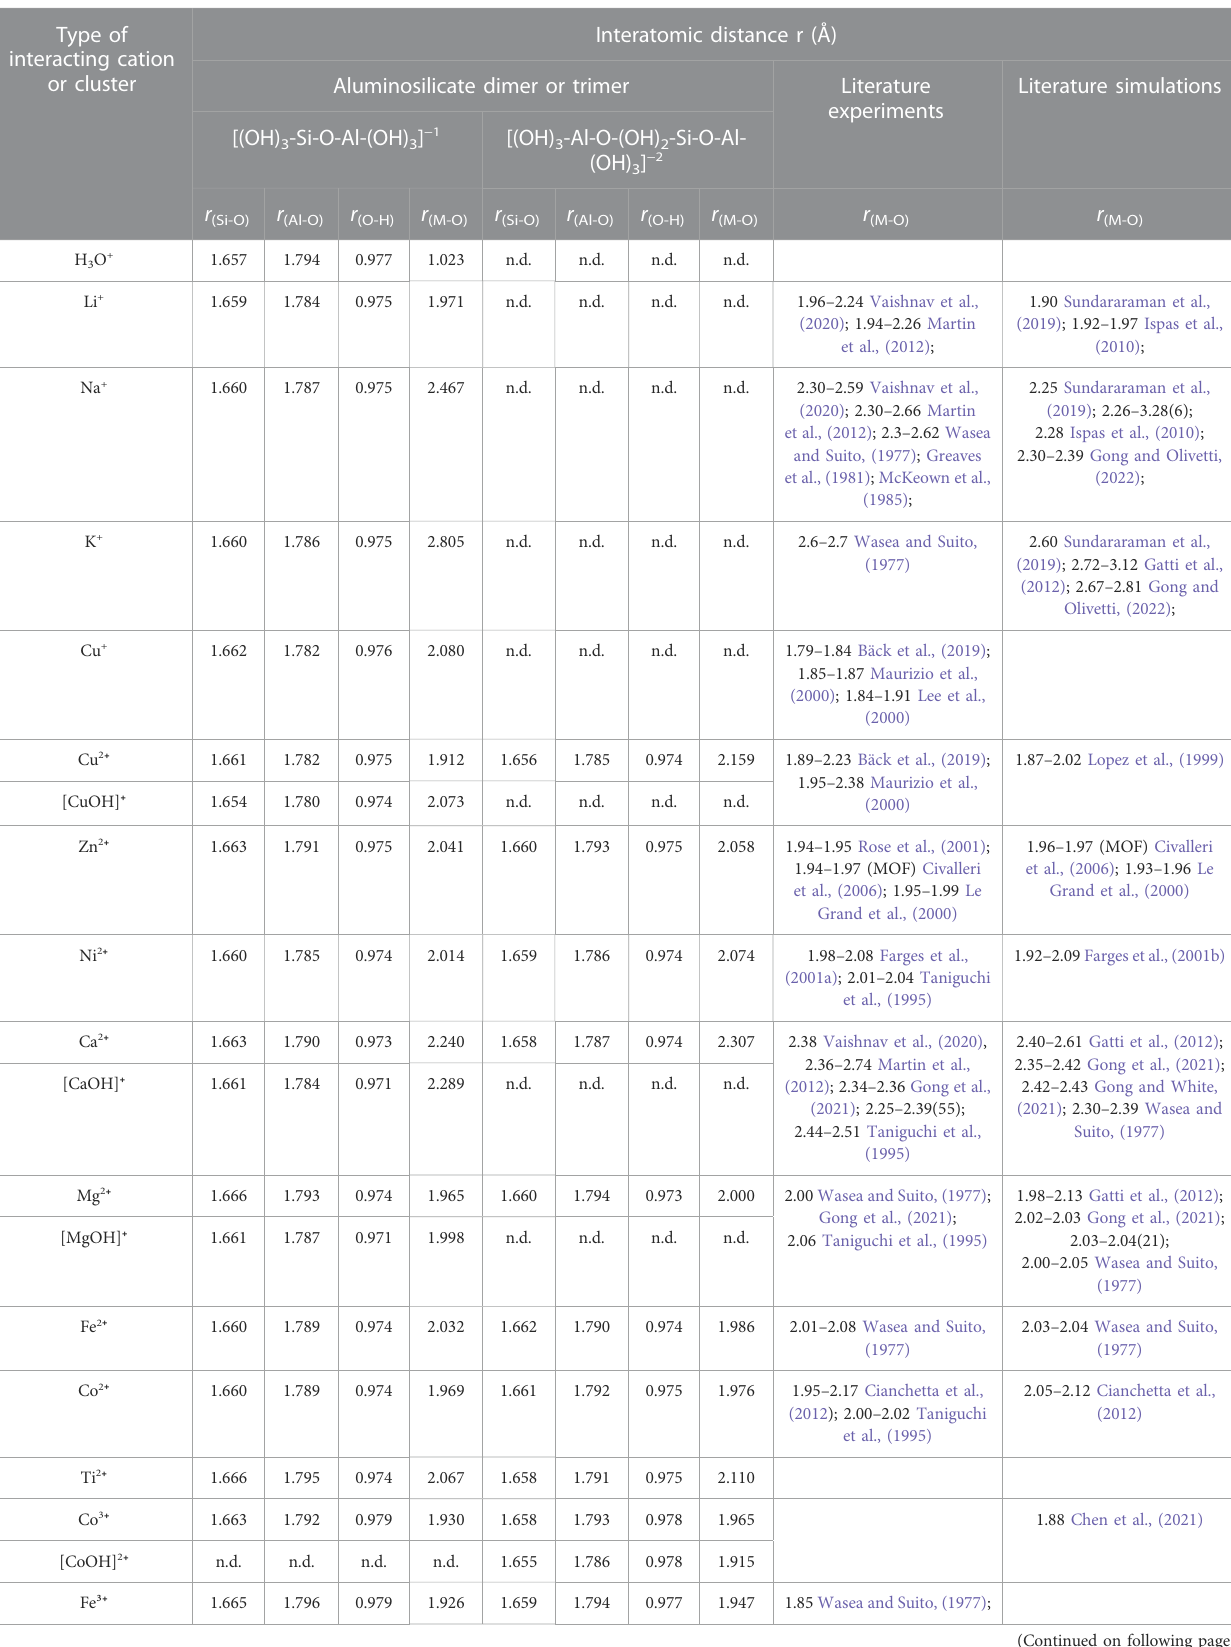
TABLE 1 Average interatomic distances (i.e., Si-O, Al-O, O-H and metal-oxygen (M-O) bond distances) for the DFT-optimized cluster structures (see Figure 2, Figure3;SupplementaryFiguresS1,S2ofSupporting Information).Alsogiveninthetableareliterature data(bothexperimentsandsimulations) forSi-O,Al-O,O- H and metal-oxygen (M-O) bond distances in silicate glasses, minerals and clusters. Type of interacting